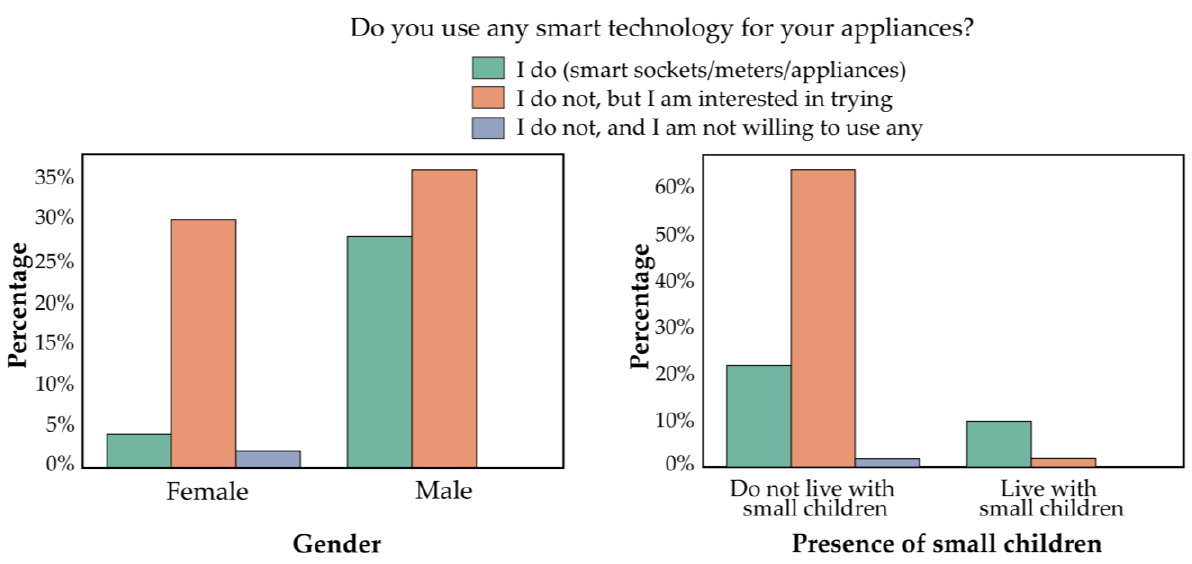
Figure 1. Countplots of the significant differences in demographics on the use of smart technologies. The y -axis expresses the percentage of respondents, while on the x -axis, the categories of the independent variables are shown.